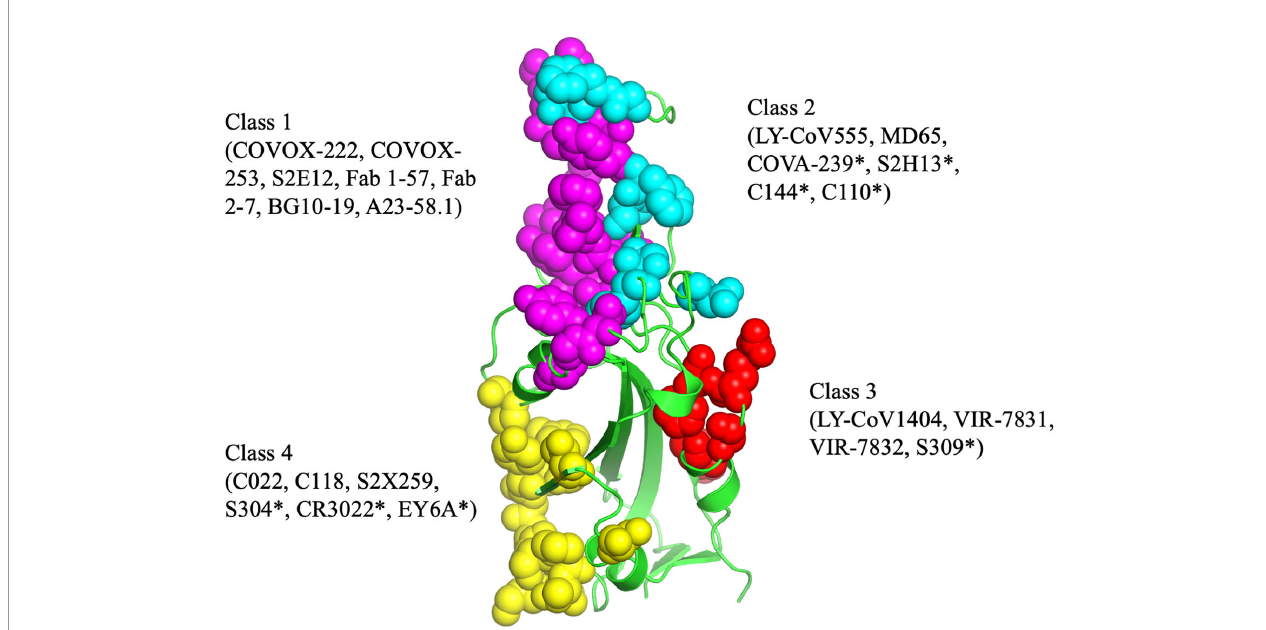
FIGURE 3 | The antibody binding epitopes in the RBD of SARS-COV-2 as classi fi ed by Barnes et al. Class 1 antibodies are represented as spheres in pink color; class 2 as cyan; class 3 as red and class 4 as yellow. Figure drawn by using Pymol; residues obtained from PDB (www.rcsb.com) using following PDB ID (7K8M, 7K90, 7JX3, 7JN5, 6ZER). *nAb not described in this